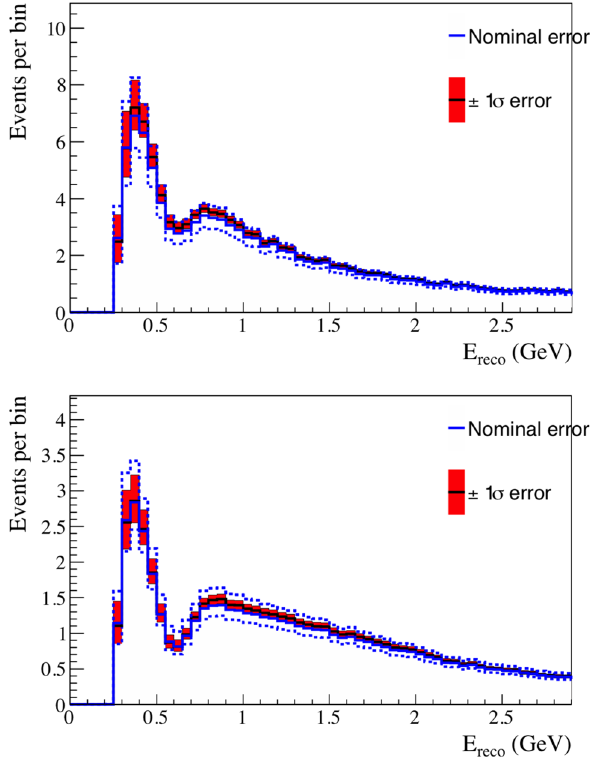
Fig. 70 The expected energy spectra of muon events in SK in neutrino beam mode (top) and anti-neutrino beam mode (bottom). The dashed histograms represent the ± 1 σ error without near detector constraints, while the solid histogram shows the error with near detector